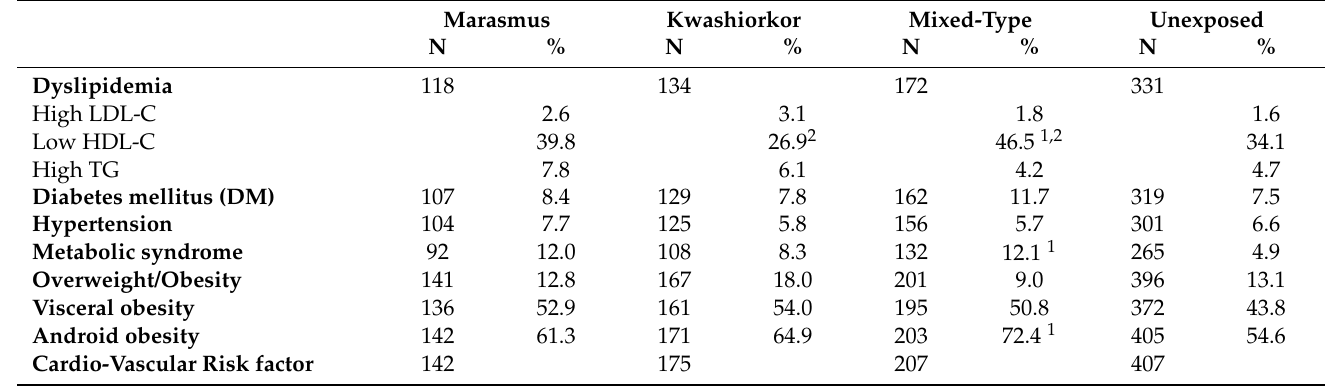
Table 2. Unadjusted differences in cardiovascular risk factors (CVRF) and NCDs prevalence in the four